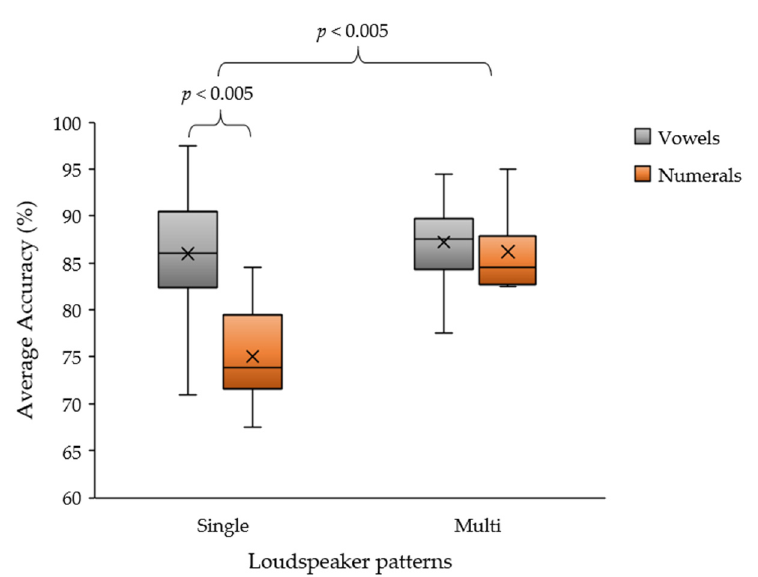
Figure 9. Average classification accuracy between vowel and numeral sounds of the auditory ERP stimulus of single and multi-loudspeaker